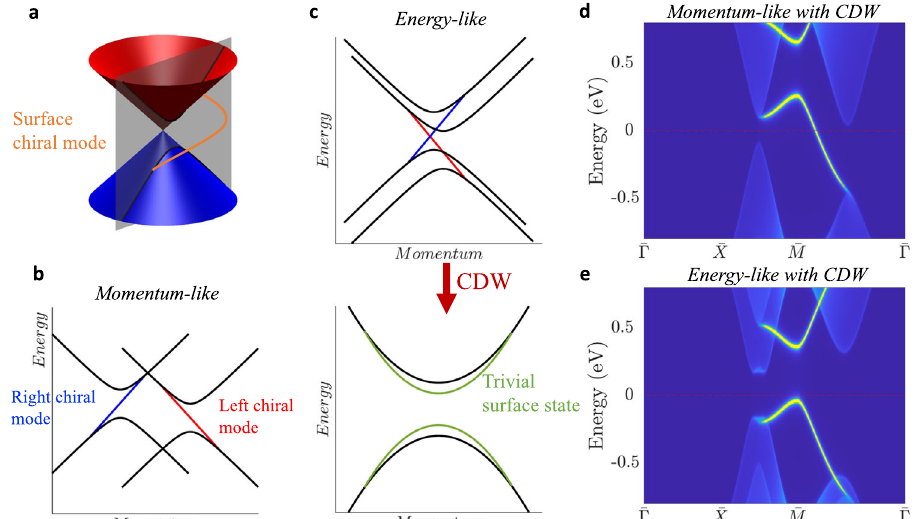
Fig.3|Causalityofthesurfacestates.a ApathawayfromtheWeylnodewiththe surfacechiralmodeconnectingtheconductionandvalencebands. b Anillustration of how the surface chiral modes do not cross each other in the momentum-like case. The red (blue) curves in ( b , c ) represent the left (right) surface chiral mode. c An illustration of how the surface chiral modes cross each other (top panel) and